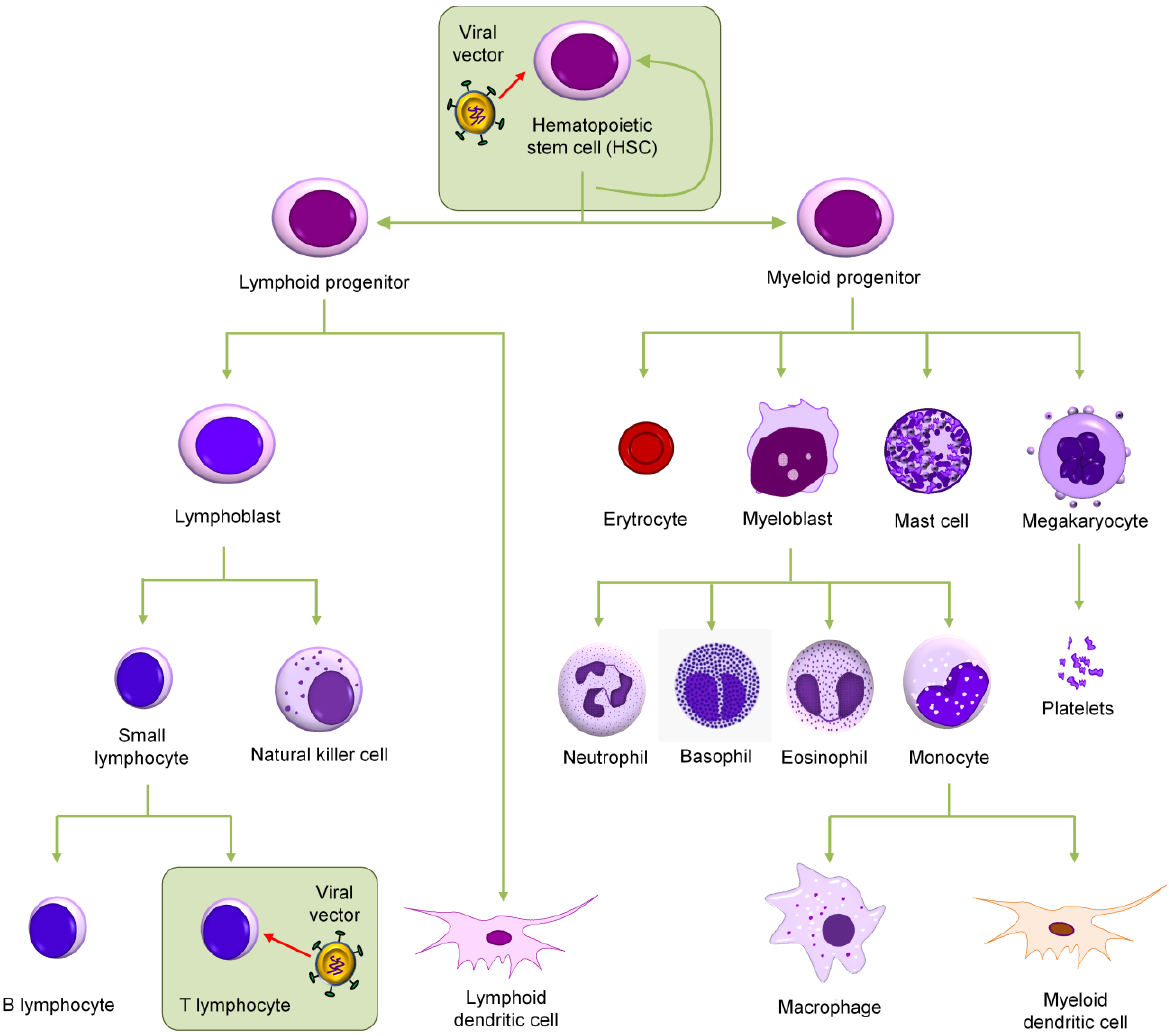
Figure 1. Target cells for an anti-HIV gene therapy. Shown is the scheme of hematopoiesis. Either hematopoietic stem cells (HSCs) from bone marrow or the mature CD4 + T cells can be targeted. These two cell populations are boxed.